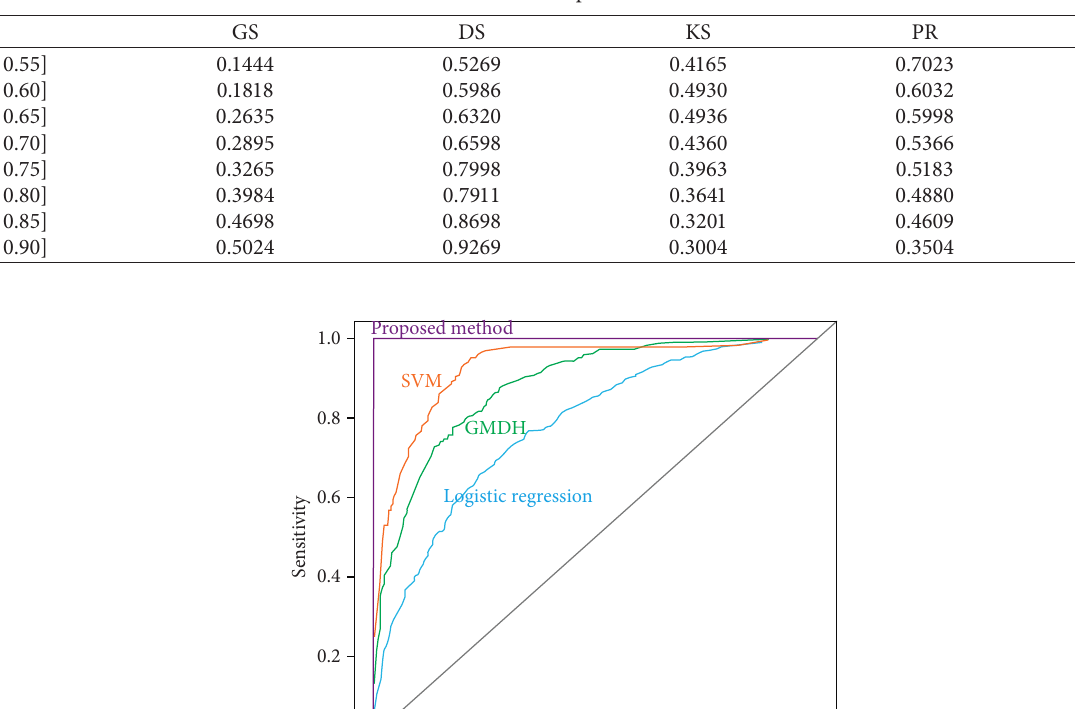
Table 9: ML model prediction results.